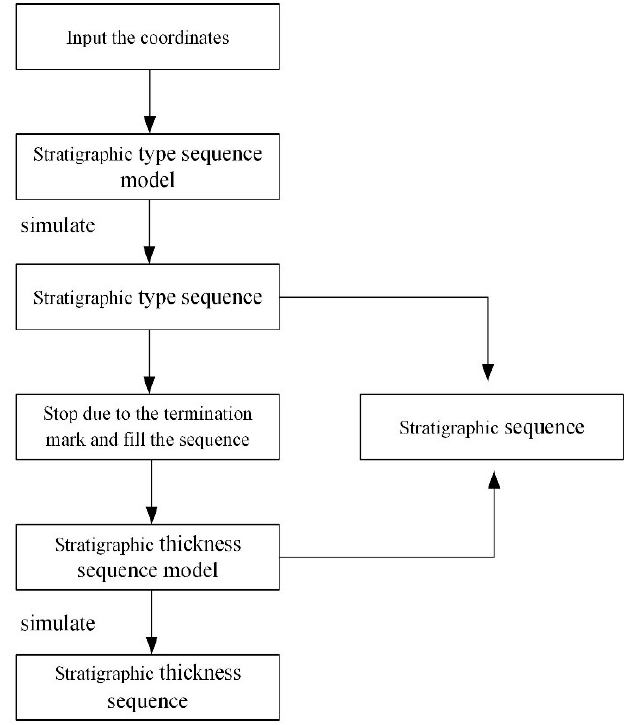
Figure 6. Simulation process of the stratum thickness sequence.